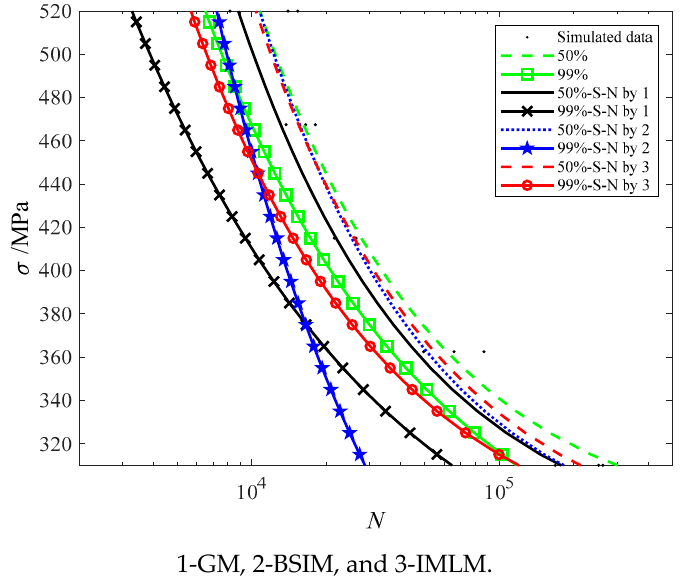
Figure 5. The fitting results of the second simulation by GM, BSIM, and IMLM.